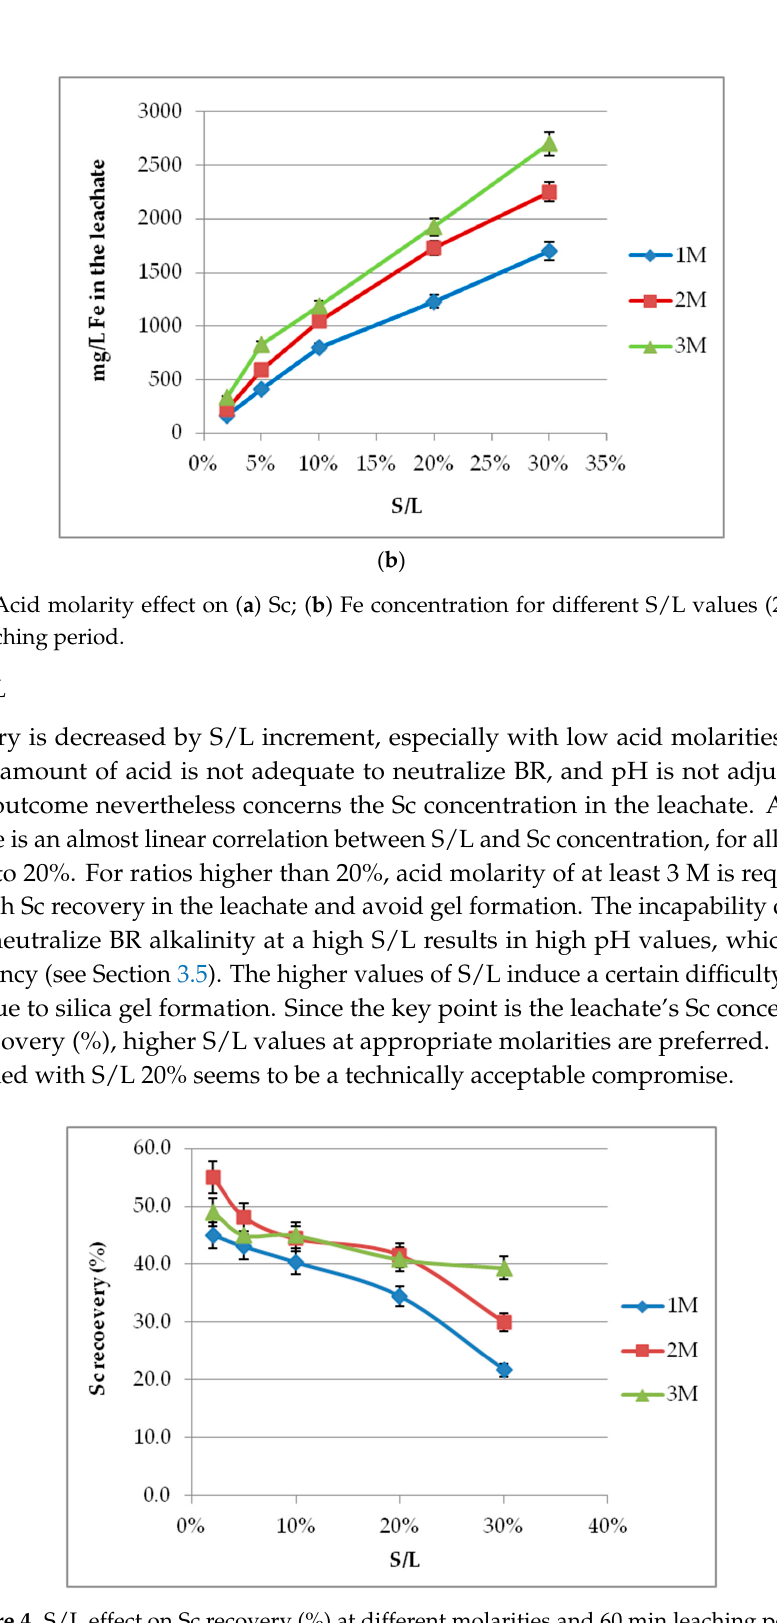
Figure 4. S/L effect on Sc recovery (%) at different molarities and 60 min leaching period.